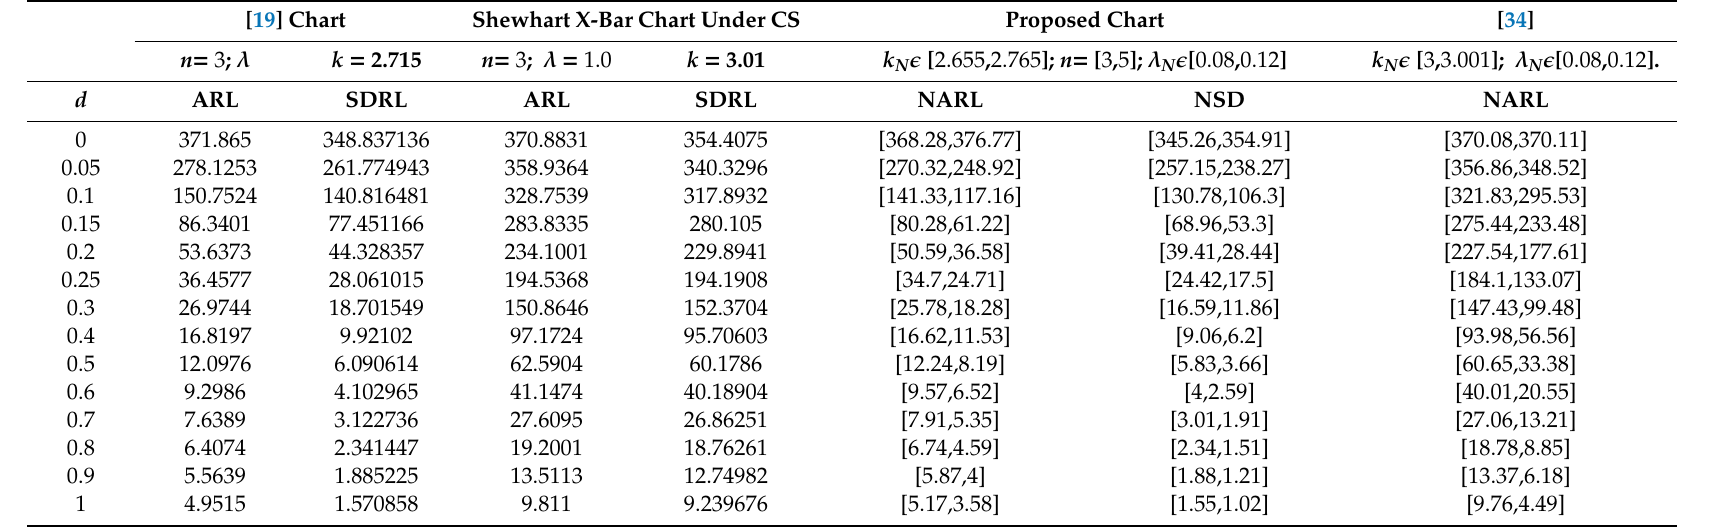
Table 5. The comparison between three